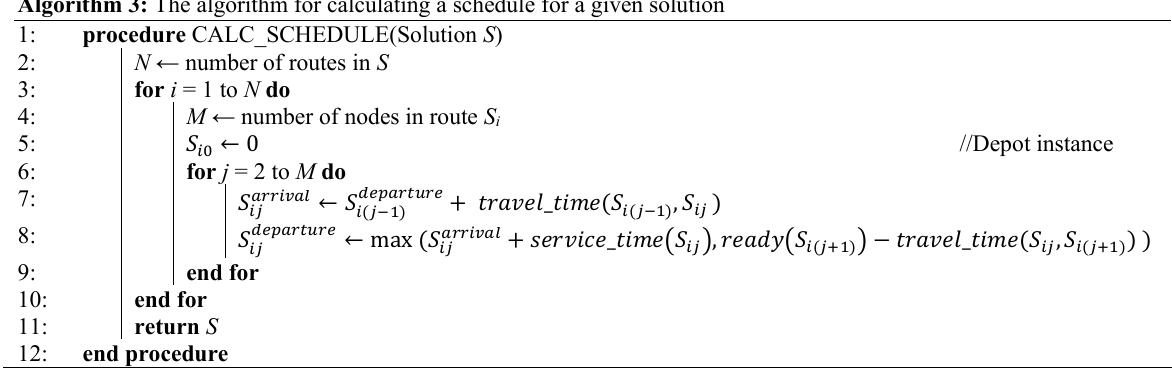
Algorithm 3: The algorithm for calculating a schedule for a given